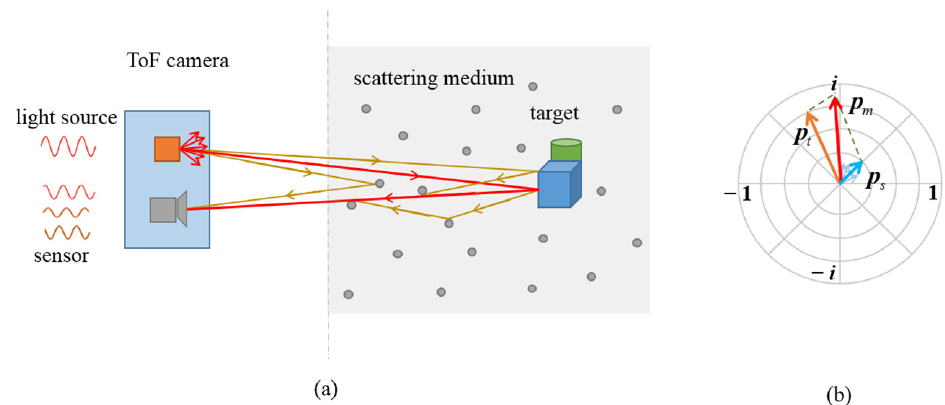
Figure 5. The imaging process and phasor representation of CW-ToF imaging in fog. ( a ) Light path of ToF imaging in the scattering scene. The red lines are the optical paths of directly reflected photons, and the brown lines represent the light paths of scattered photons. ( b ) Phasor representation of ToF measurements in fog. The observed phasor in red can be decomposed into the target phasor in orange and the scattering phasors in blue.